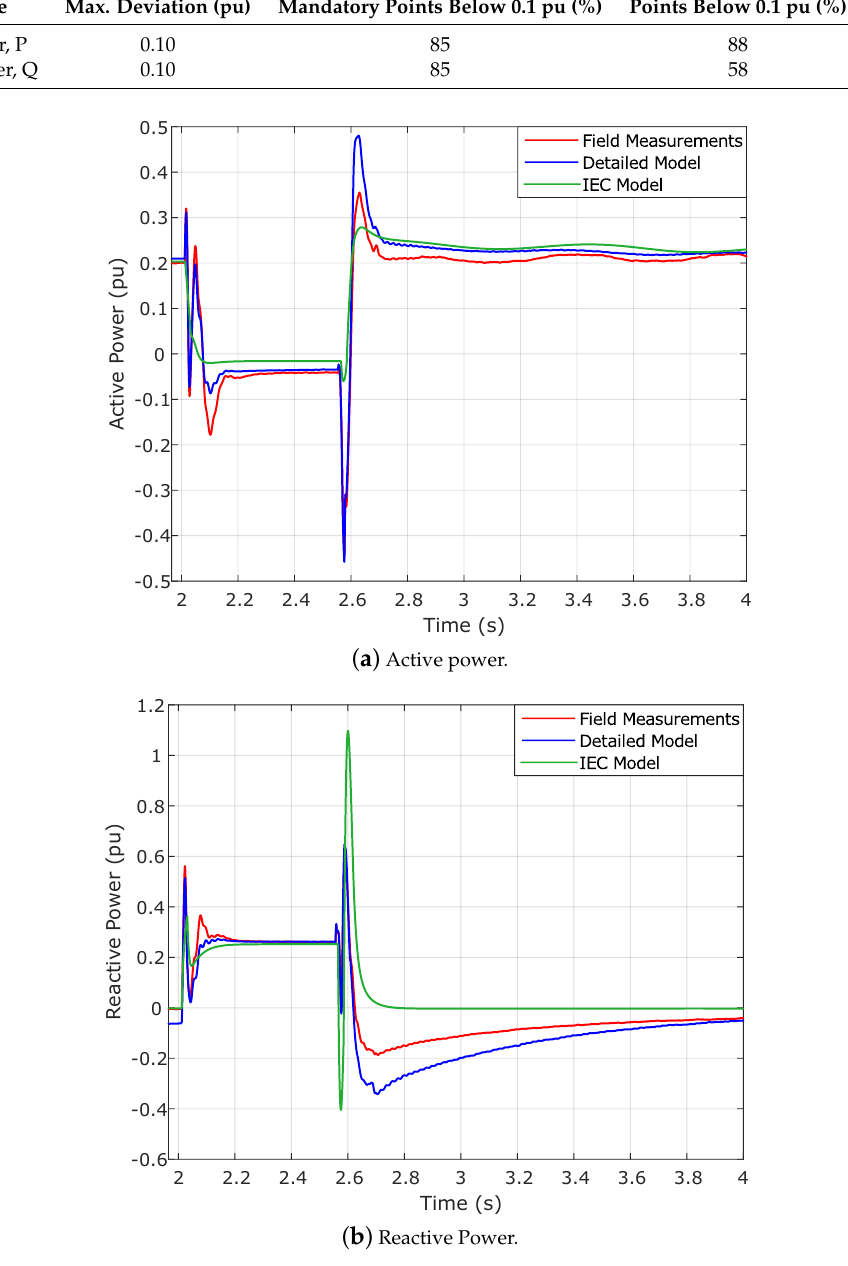
Figure 7. Active and reactive power at measurement point 1 (20 kV). WT operating at partial load